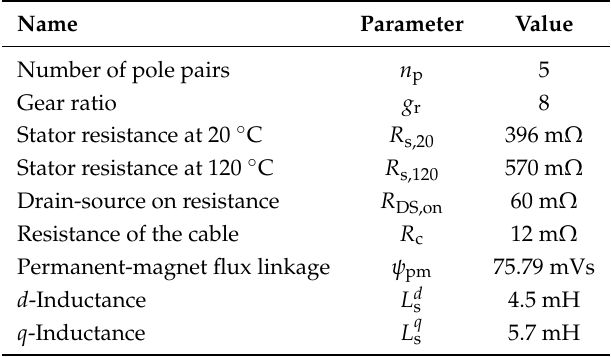
Table 1. Parameters of the electrical